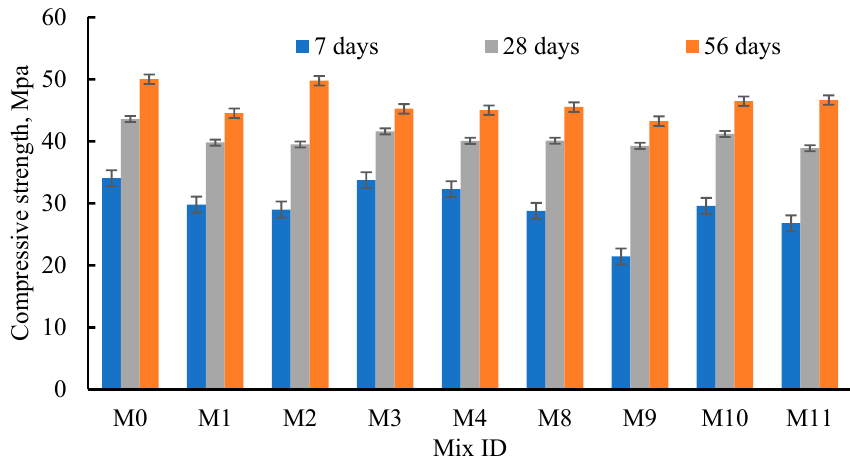
Figure 5. Effect of the RFCA and RFNA on concrete compressive strength.